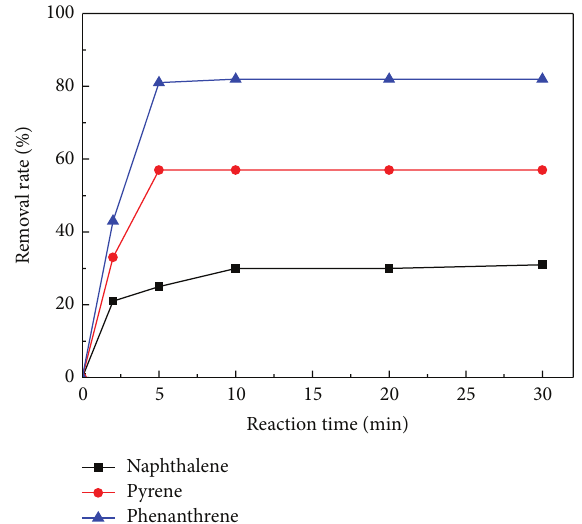
Figure 4: Influence of K 2 FeO 4 concentration on aromatic hydrocar- bons conversion and